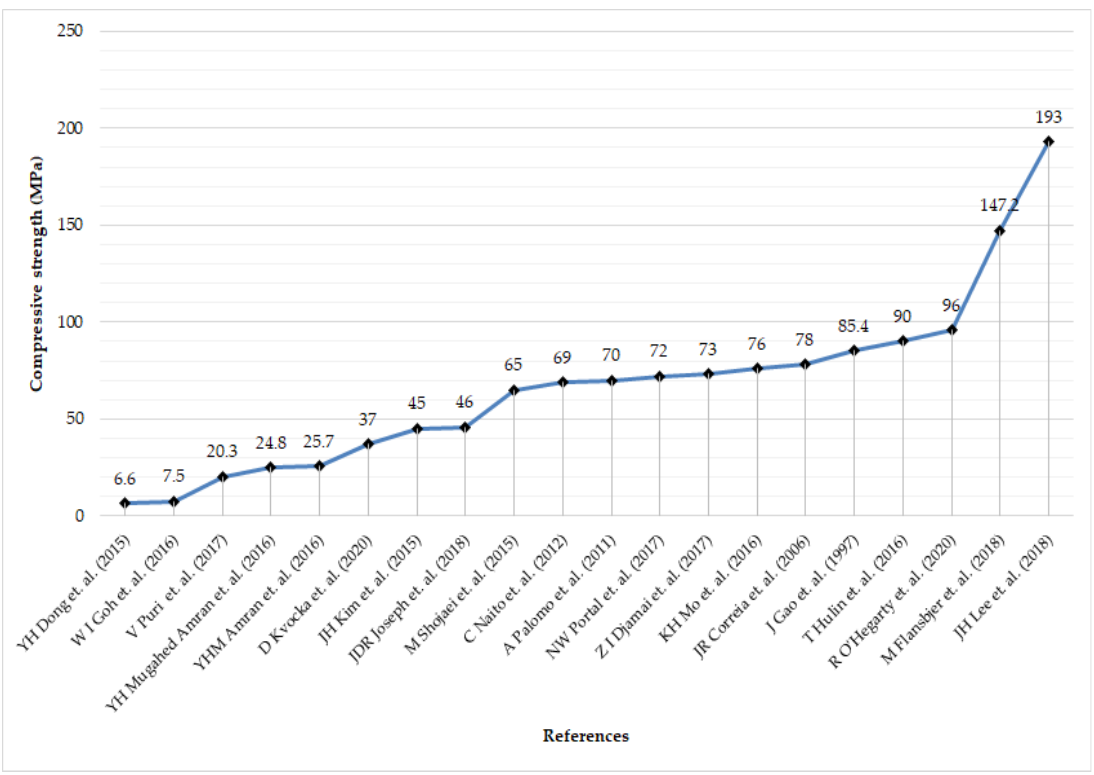
Figure 3. Compressive strength in the presented